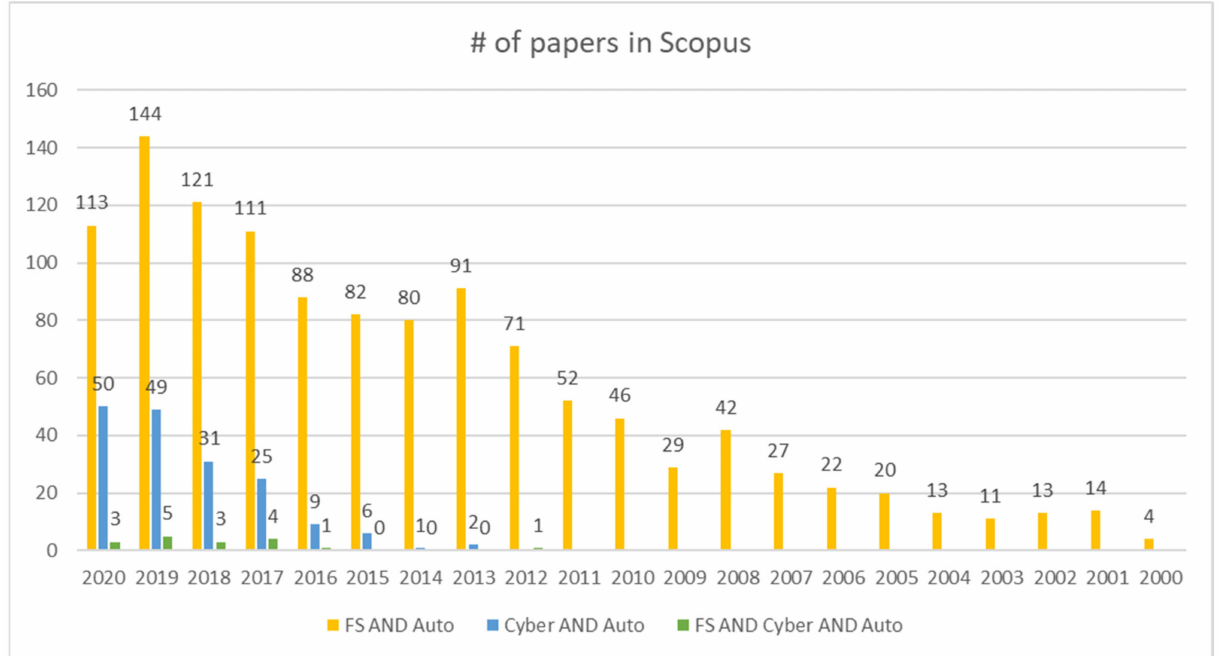
Figure 3. Numbers of publications in the Scopus